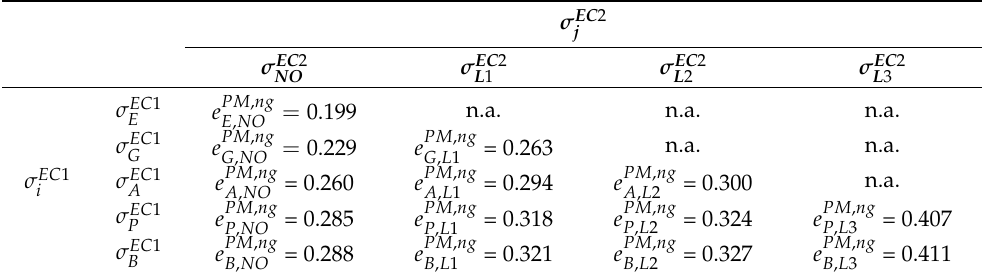
Table 9. Computational results of the virtual PM emission in kg within one